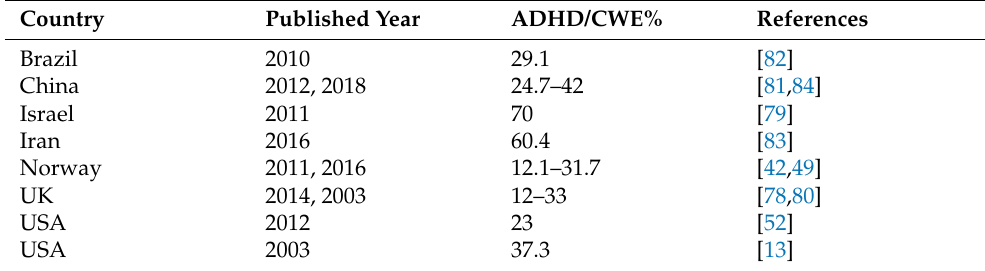
Table 2. Prevalence of ADHD in